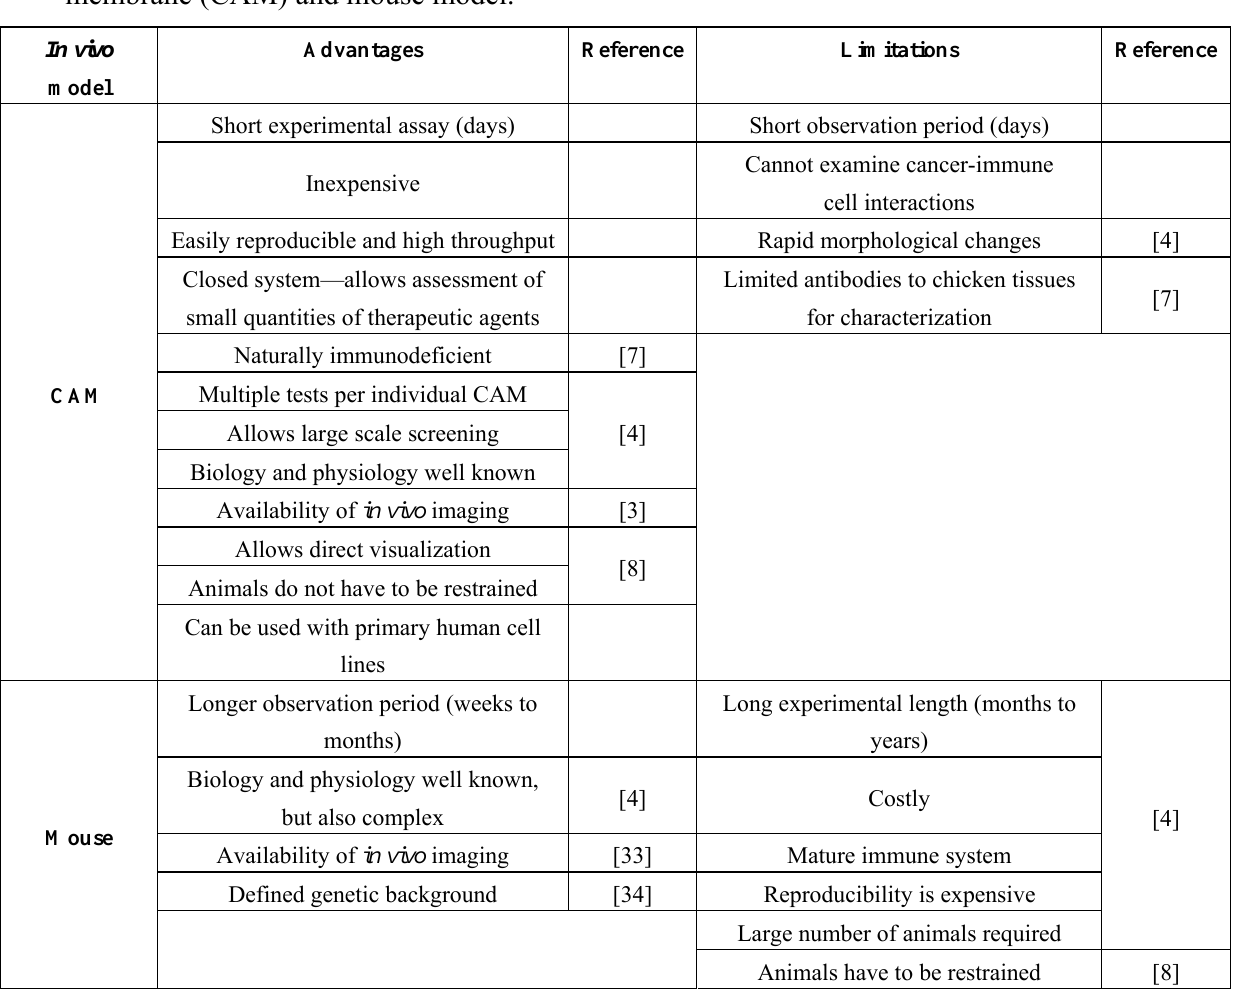
Table 1. Comparison of the advantages and limitations of the chick chorioallantoic membrane (CAM) and mouse